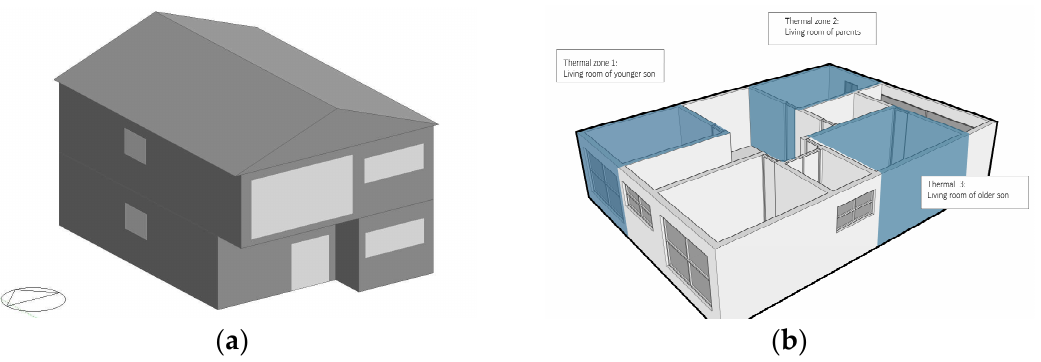
Table 5. Monthly measured and simulated electricity consumption data for residential home.